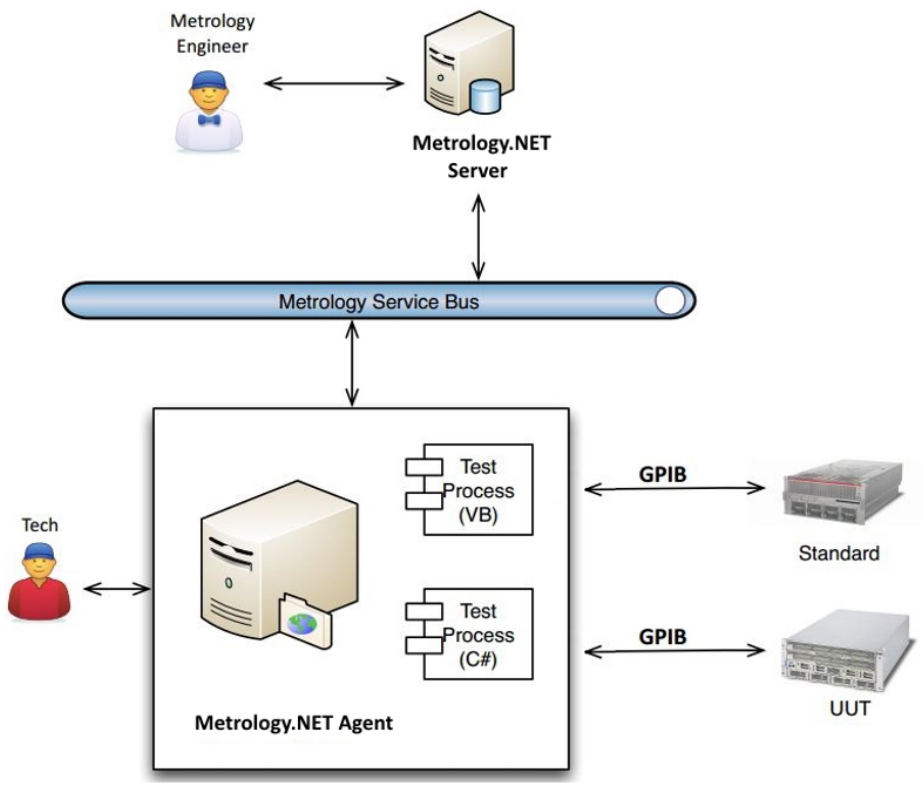
Figure 2. An overview of the Metrology.NET